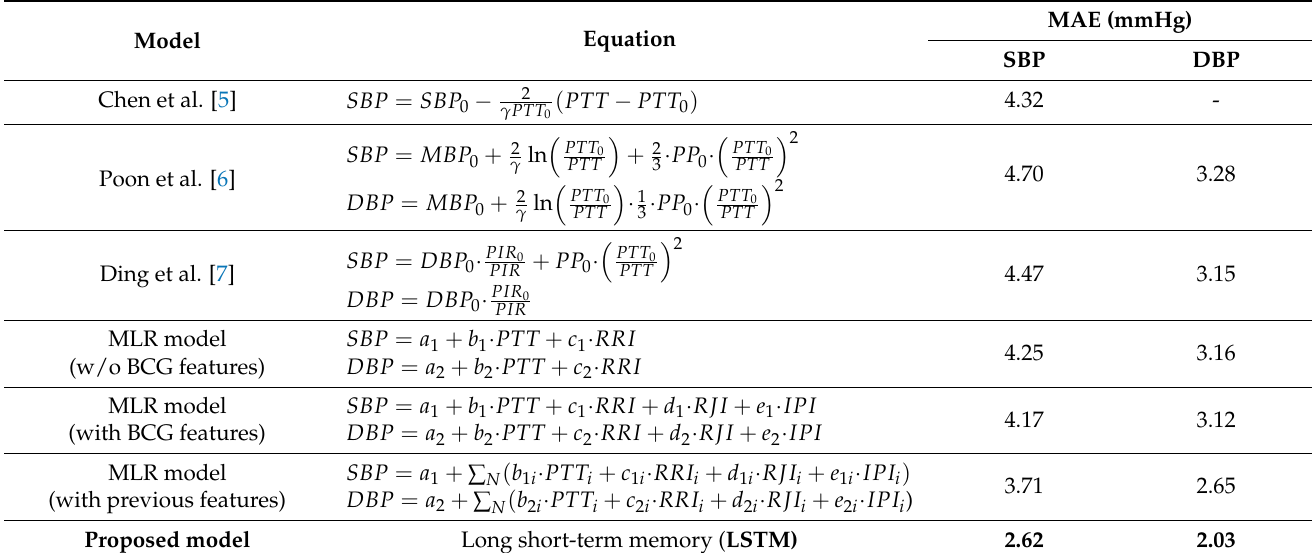
Table 8. Comparison with other